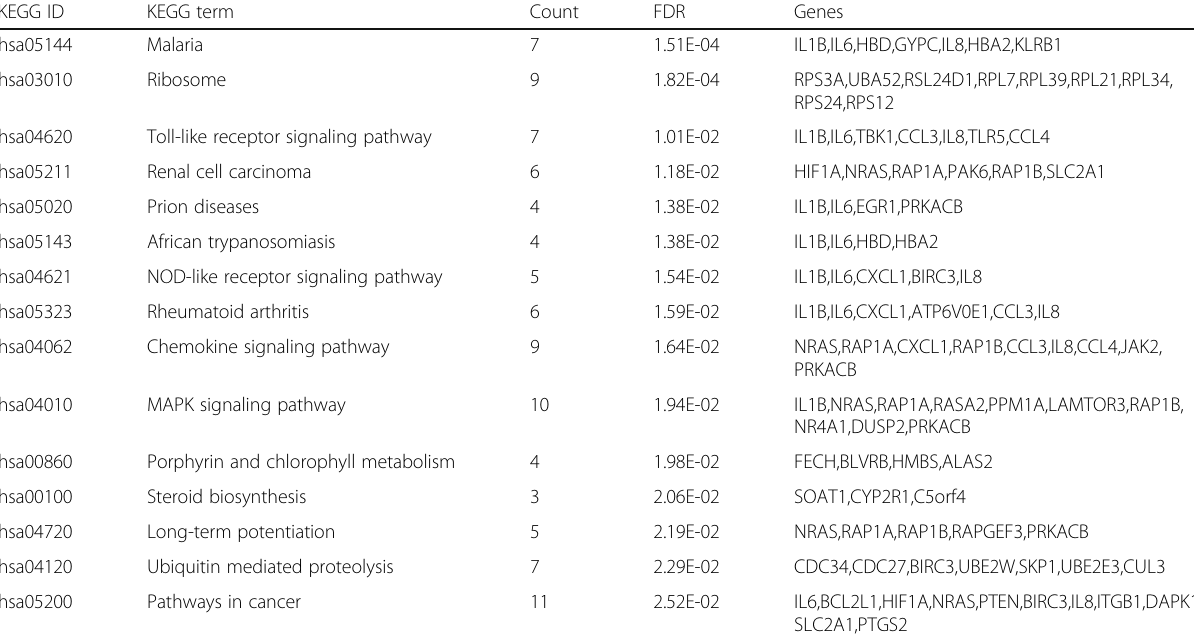
Table 3 Highly significantly enriched pathways for differentially expressed genes in T2D + CAD group KEGG